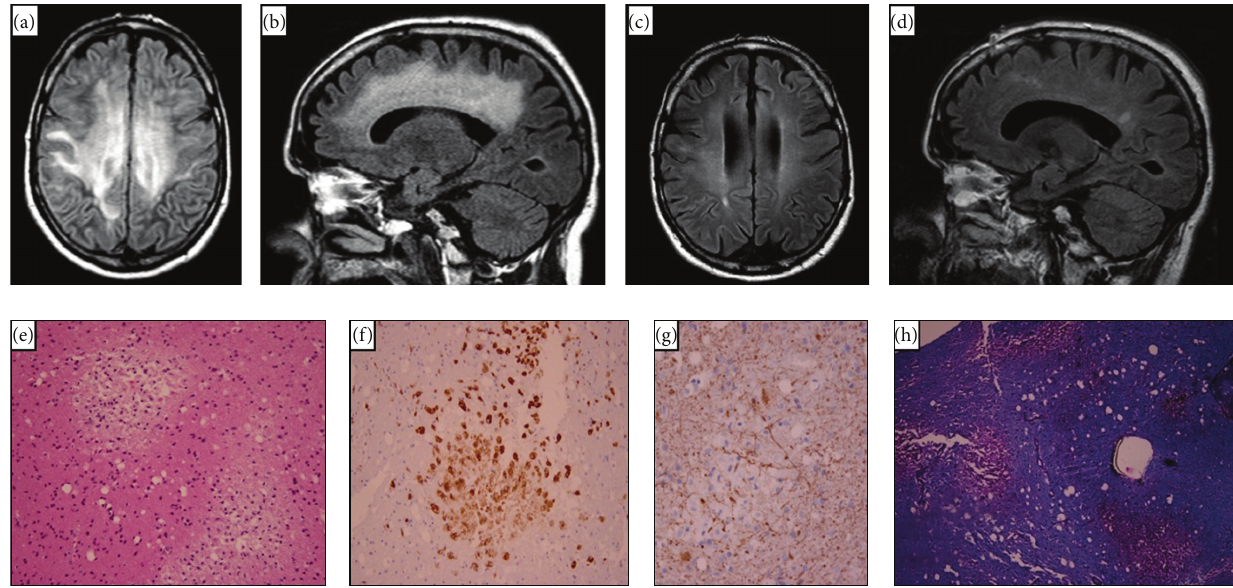
Figure 1: (a) Axial (T2/FLAIR) MRI showing supratentorial white matter (WM) hyperintensities extending from the periventricular region to the subcortical fibers. (b) Sagittal (T2/FLAIR) MRI showing diffuse periventricular WM intensities. (c) Axial (T2/FLAIR) MRI showing interval improvement and resolution of the periventricular WM lesions. (d) Sagittal (T2/FLAIR) MRI demonstrating the improvement of the periventricular WM lesions. (e) H&E stain shows areas of pallor containing macrophage that represent areas of demyelination (original magnification 200x). (f) Clusters of macrophages in the areas of demyelination are highlighted by immunohistochemical staining for macrophage marker CD68 (original magnification 200x). (g) Relative preservation of axons that are seen to traverse the macrophage rich areas of demyelination is demonstrated on neurofilament immunohistochemical stain (original magnification 400x). (h) Multiple pink areas of myelin loss are present in the background of normal appearing blue staining cerebral white matter on Luxol Fast Blue/PAS stain (original magnification